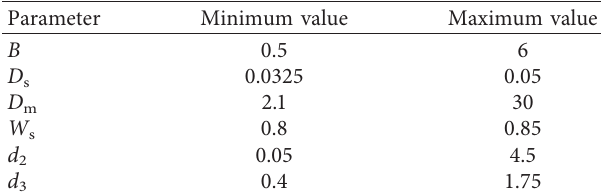
Table 2: Table of